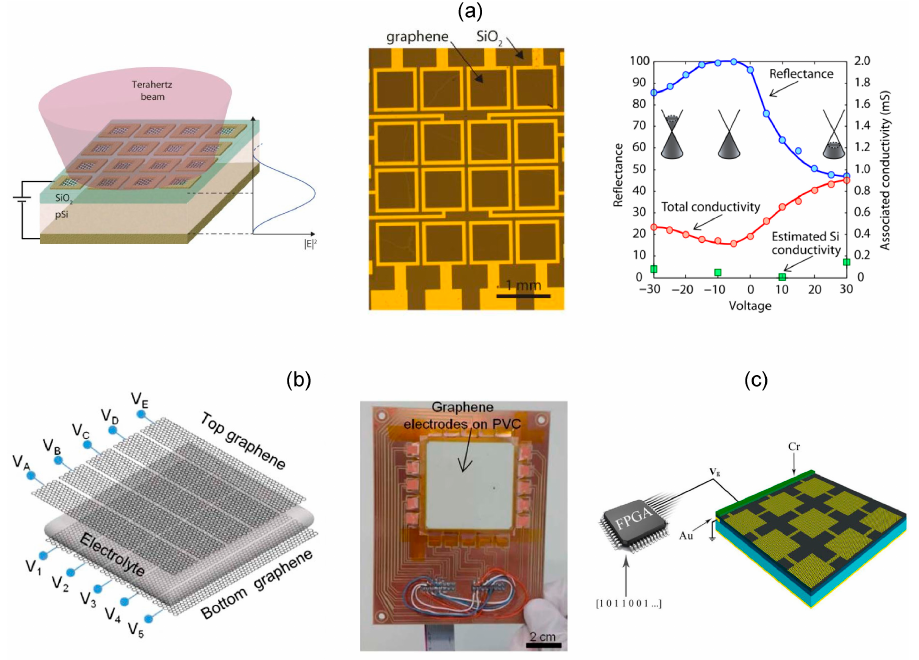
Figure 7. Graphene-based THz SLMs. ( a ) Electric-driven graphene reflective SLM ( left ), the micro- scopic image ( middle ), and the variation of the reflectivity with the bias voltage ( right ). Reproduced with permission from [81]. Copyright 2013 Optica Publishing Group. ( b ) Graphene SLM based on ionic liquid electrolyte gating method for large modulation depth, the geometry ( left ) and the photo of the device ( right ). Reproduced with permission from [82]. Copyright 2015 Optica Publishing Group. ( c ) Reflective SLM for phase modulation using patterned graphene. Reproduced with permission from [83]. Copyright 2018 Elsevier B.V.